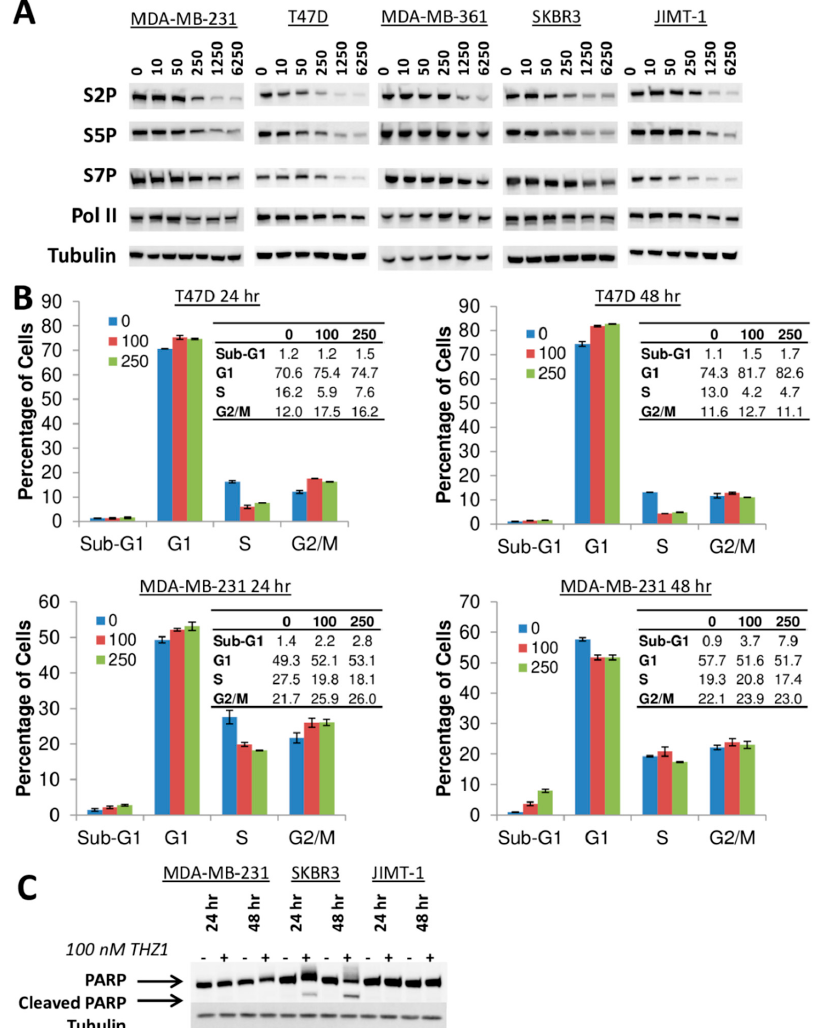
Figure 6. Effects of THZ1 (nM concentrations) on phosphorylation of RNA Pol II, cell cycle and apoptosis. ( A ) Immunoblotting for expression of phosphorylated RNA Pol II (S2P, S5P, S7P) and total